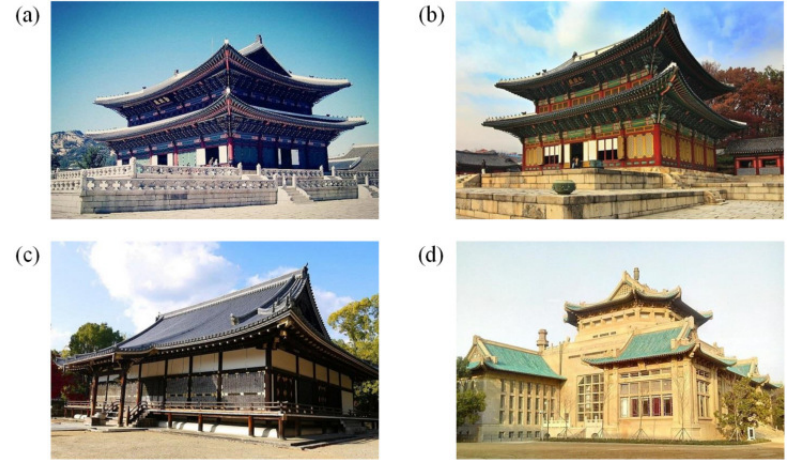
Figure 1. Ancient and antique Chinese-style architecture. ( a ) Qinzheng Palace in Beijing, China; ( b ) Renzheng Palace in Seoul, Korea; ( c ) Renhe Temple in Kyoto, Japan; ( d ) antique buildings at Wuhan University,